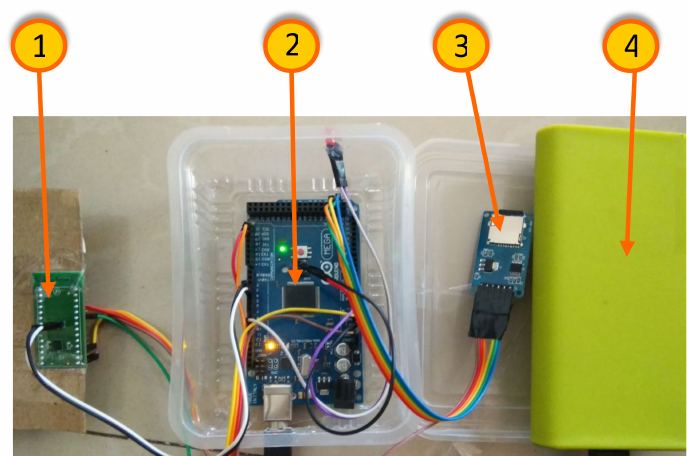
Figure 5. IMU Data Logger.